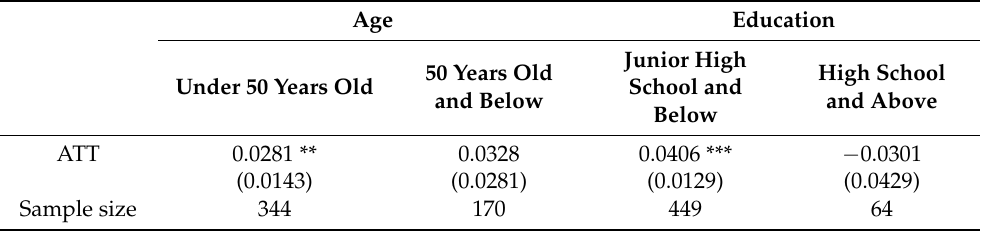
Table 9. Heterogeneity analysis based on head of household